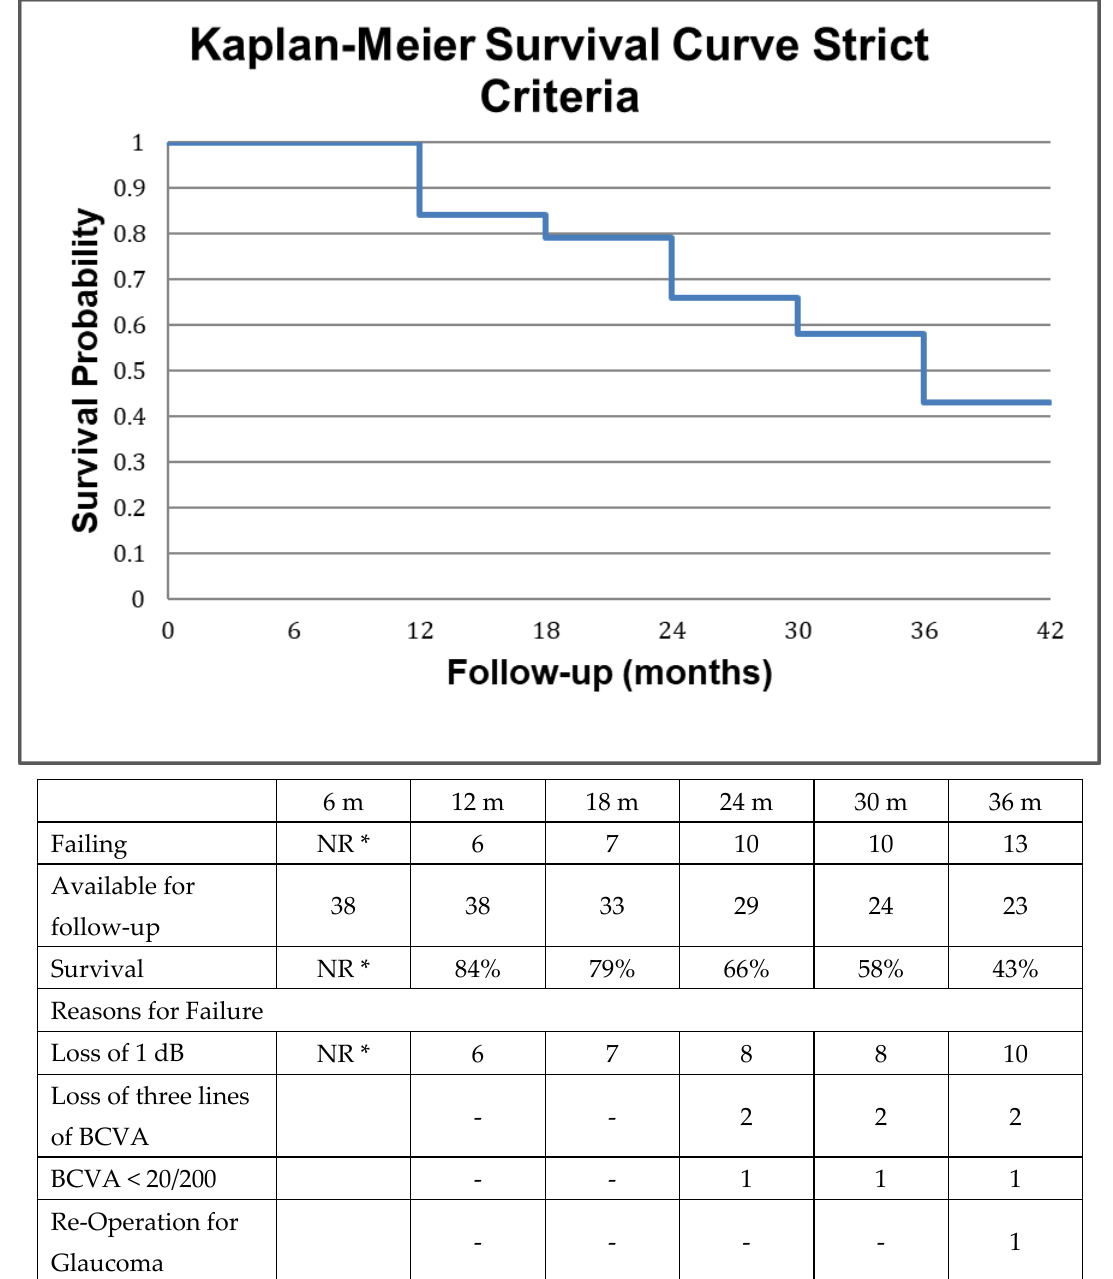
Figure 2. Survival of visual function according to the strict criteria along with the reasons for failure as defined in the method section. Briefly failure was defined as loss of 1 dB in mean deviation in standard automated perimetry or loss of three lines in best corrected visual acuity or decline of Snellen best corrected visual acuity below the level of 20/200 or re-operation for glaucoma during the follow-up period. The individual reasons for failure may occasionally add up to more than the sum of failures because of patients failing for more than one reason. NR *: Not reported due to scarcity of VF data at 6 months.